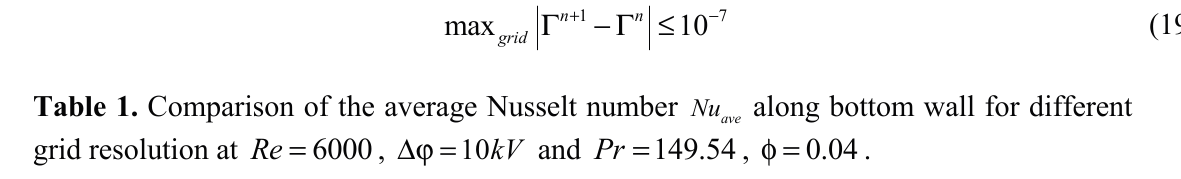
Nu along bottom wall for different ave